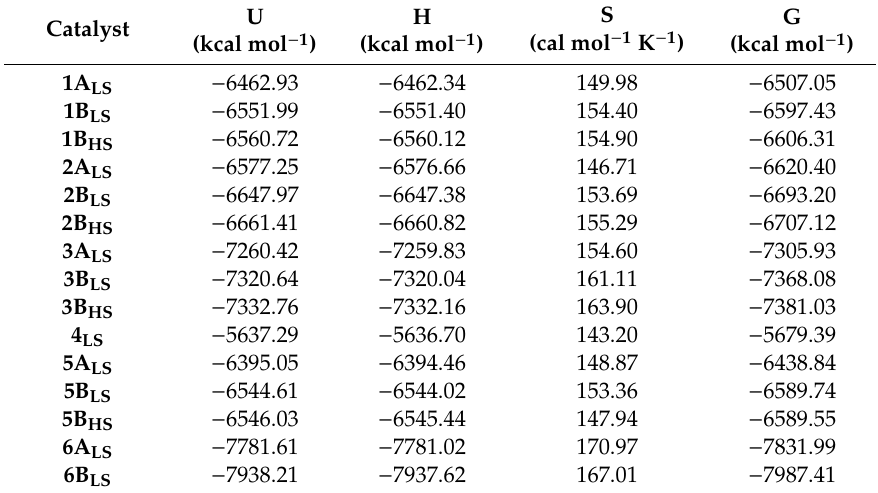
Table 2. Calculated energies in the gas phase of optimized Ni(II)–PyMAC structures in their low-spin ( S = 0) and high-spin ( S = 1) states at 298.15 K and 1 atm. U, H, S, and G are the internal energy, enthalpy, entropy, and Gibbs free energy, respectively, corrected with ZPE (zero-point vibrational energy).